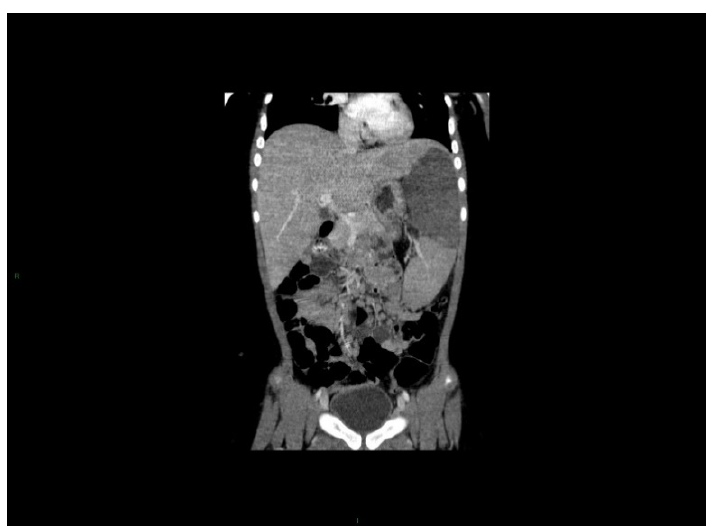
Figure 5. Splenic infarction at diagnosis of CML. A seven years-old girl presented with abdominal pain, splenomegaly and massive leukocytosis. Coronal CT after contrast injection showed an enlarged spleen with a large central hypodensity, well limited, with low enhancement and rectilinear borderlines. Photography by courtesy of Prof. Arnaud Y. Petit, Paris, France. For details and outcome see reference [90].